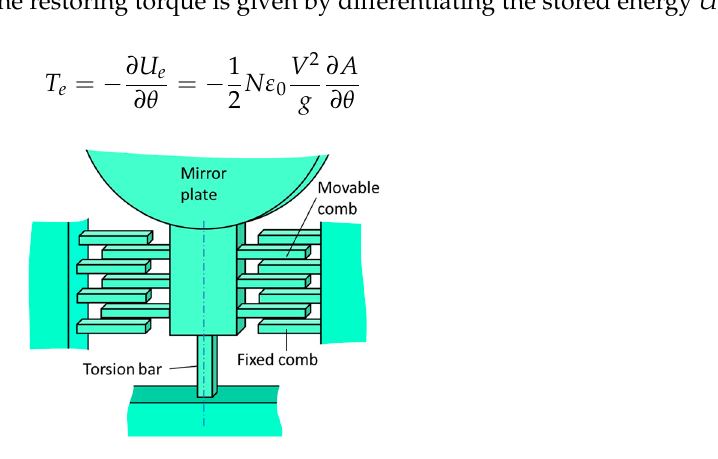
Figure 1. Schematic diagram of torsion-bar with electrostatic spring consisting of comb electrodes.